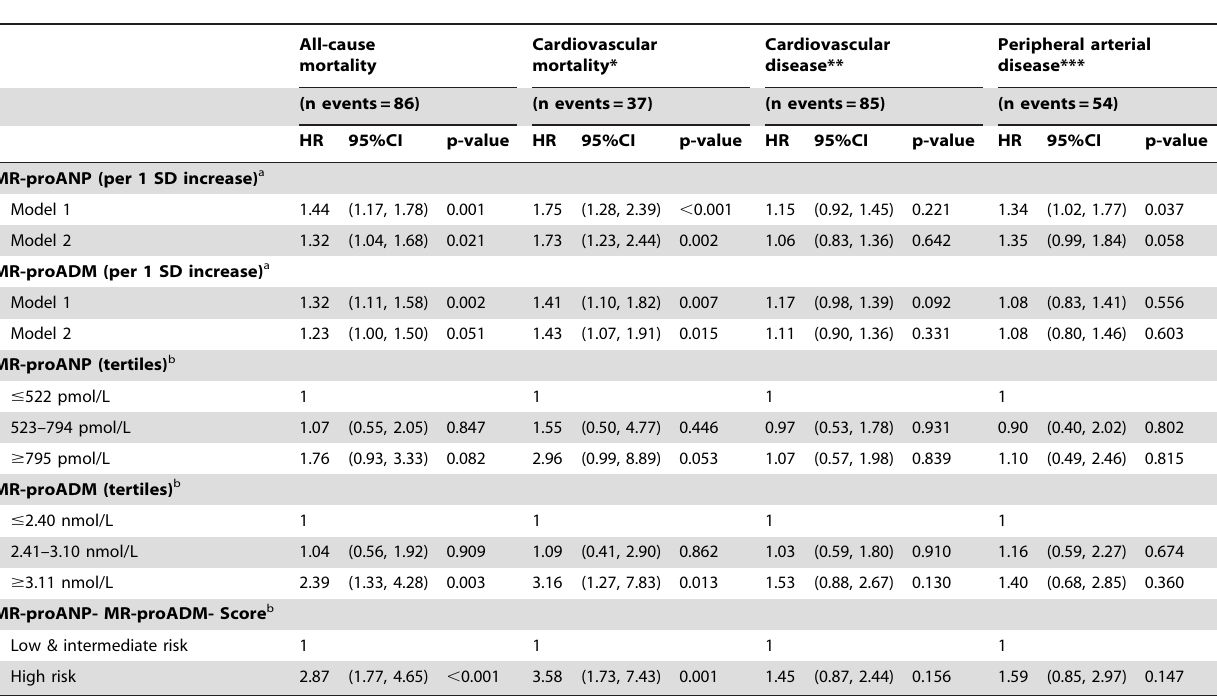
Table 3. The association of MR-proANP and MR-proADM as well as MR-proANP tertiles and MR-proADM tertiles and furthermore for patients with high risk (both MR-proANP and MR-proADM in the highest tertile) with different endpoints using multiple Cox- proportional hazards